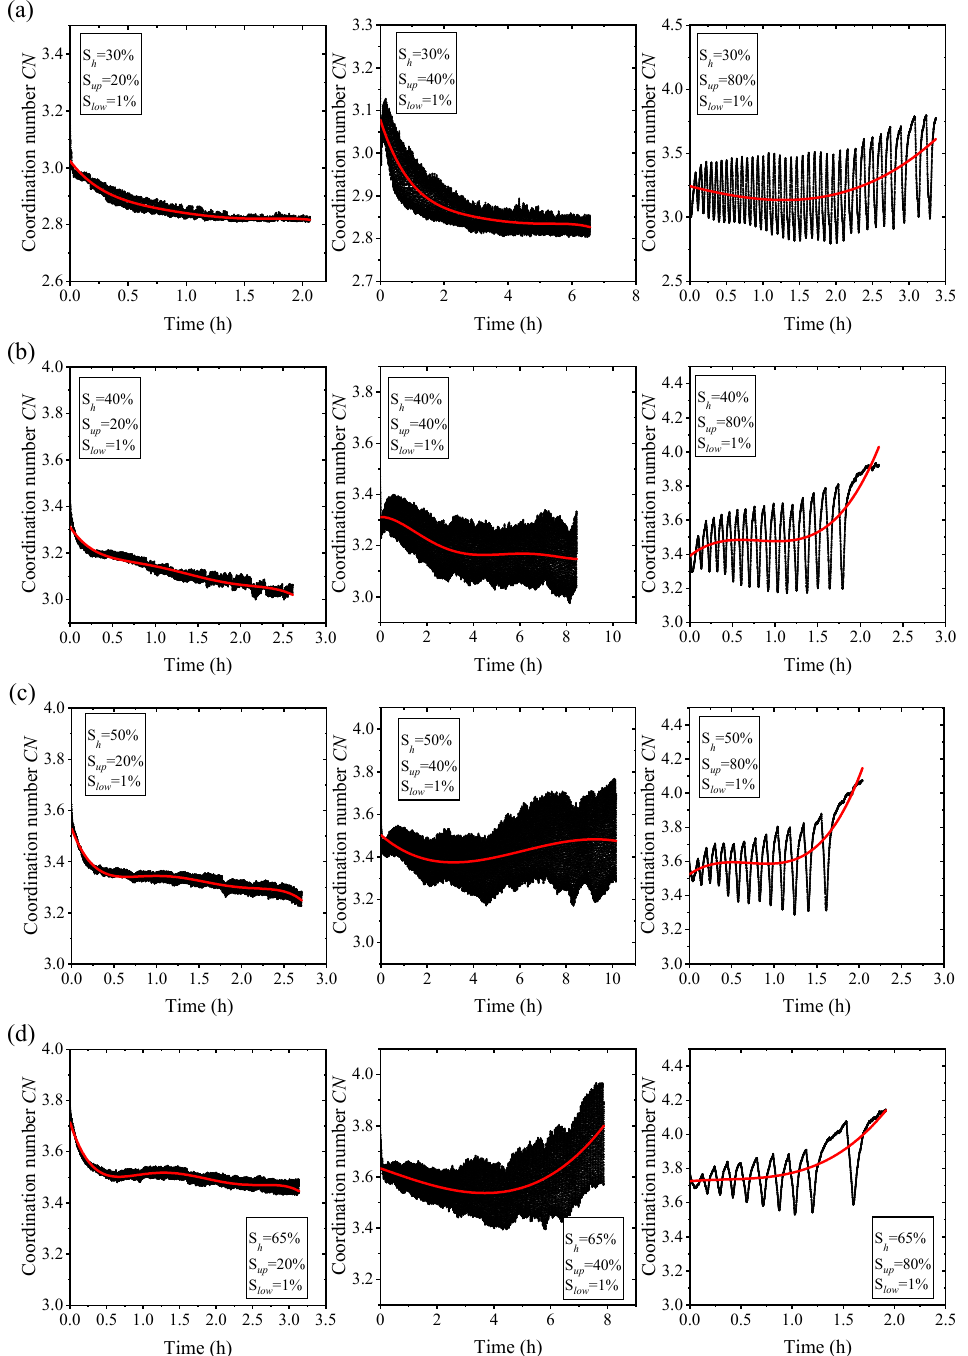
Figure 12. The evolution of the coordination number under different dynamic amplitude conditions for the MHS with different S h values. (a) S h = 30%; (b) S h = 40%; (c) S h = 50%; (d) S h = 65%.